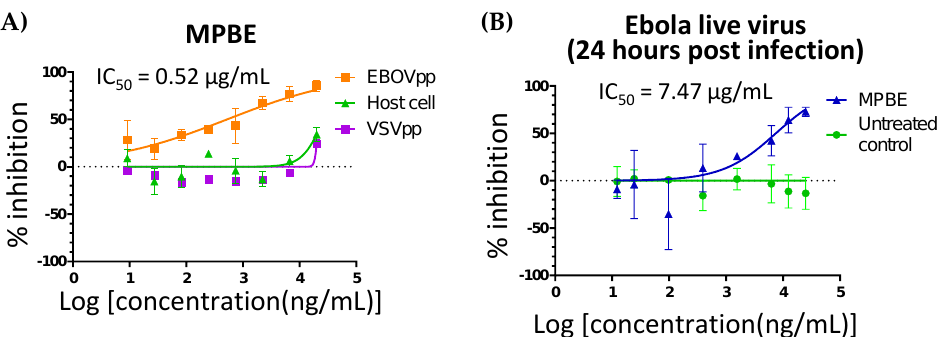
Figure 1. Antiviral IC 50 value for MPBE. ( A ) The in vitro dose response was evaluated in A549 cells against EBOVpp at eight twofold serial dilution concentrations with three independent experiments. ( B ) The in vitro dose response was evaluated in VERO E6 cells against infectious EBOV. The IC 50 and CC 50 values were determined by fitting dose–response curves with the equation log (inhibitor) vs. normalized response–variable slope to the data using GraphPad Prism software.